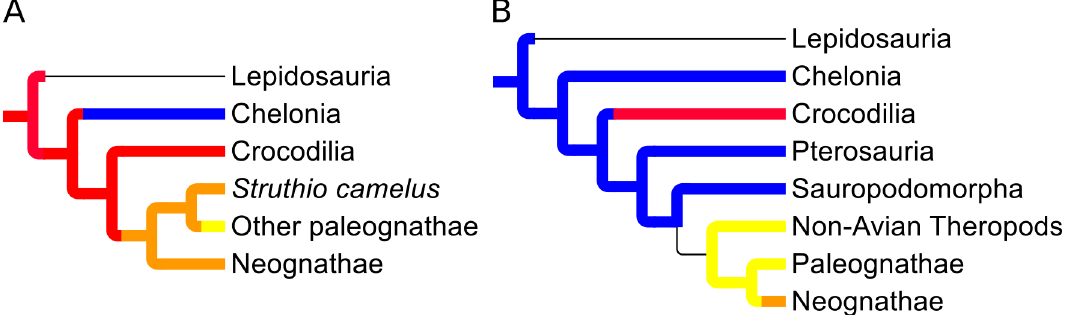
Fig 1. Summary of the most likely ancestral care strategies for major diapsid clades. Blue = no care, red = maternal care, orange = biparental care, yellow = paternal care, uncolored = heterogeneous/ambiguous. A = Extant taxa, B = Extinct and extant